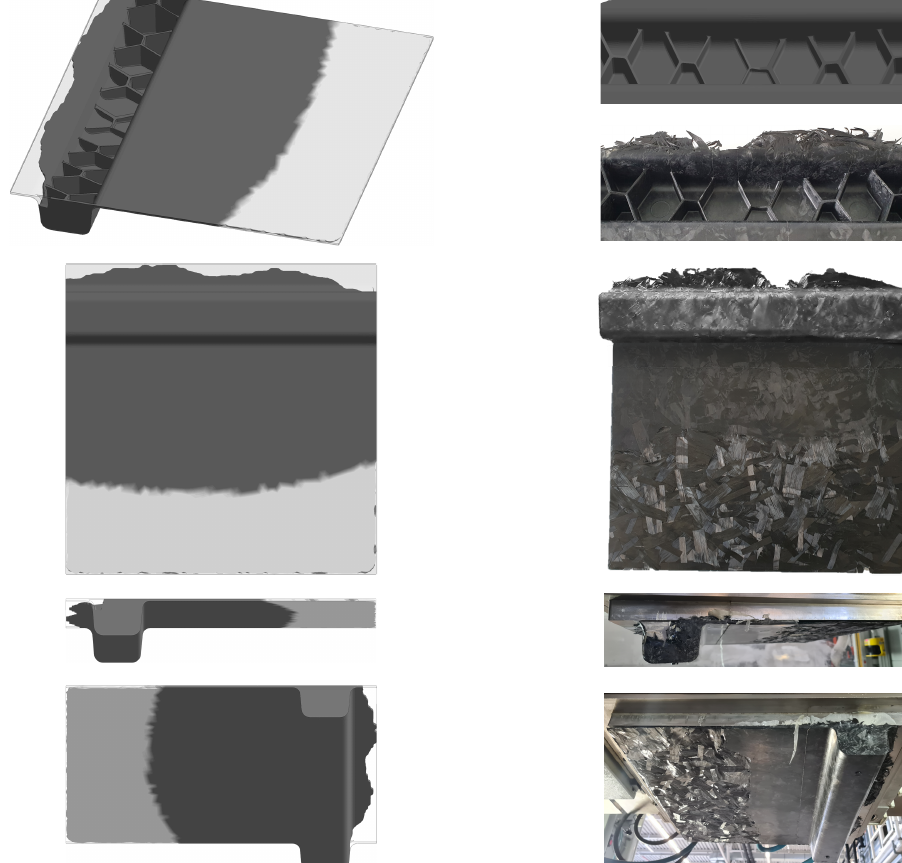
Figure 15. 3D TIMON CompositePRESS fill simulation status compared to a real HexMC short shot using 4.00 mm shims (numerical and real short shot are shown from different viewing angles).